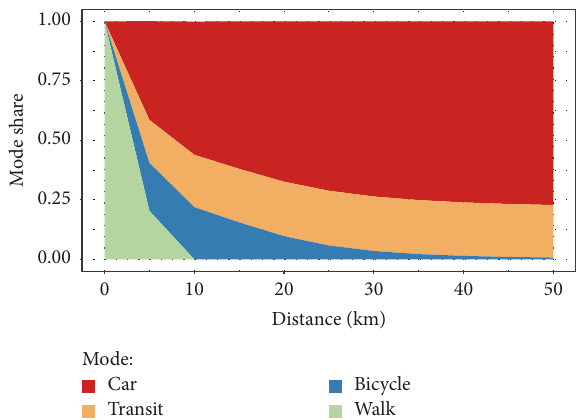
Figure 3: Mode share by distance: first